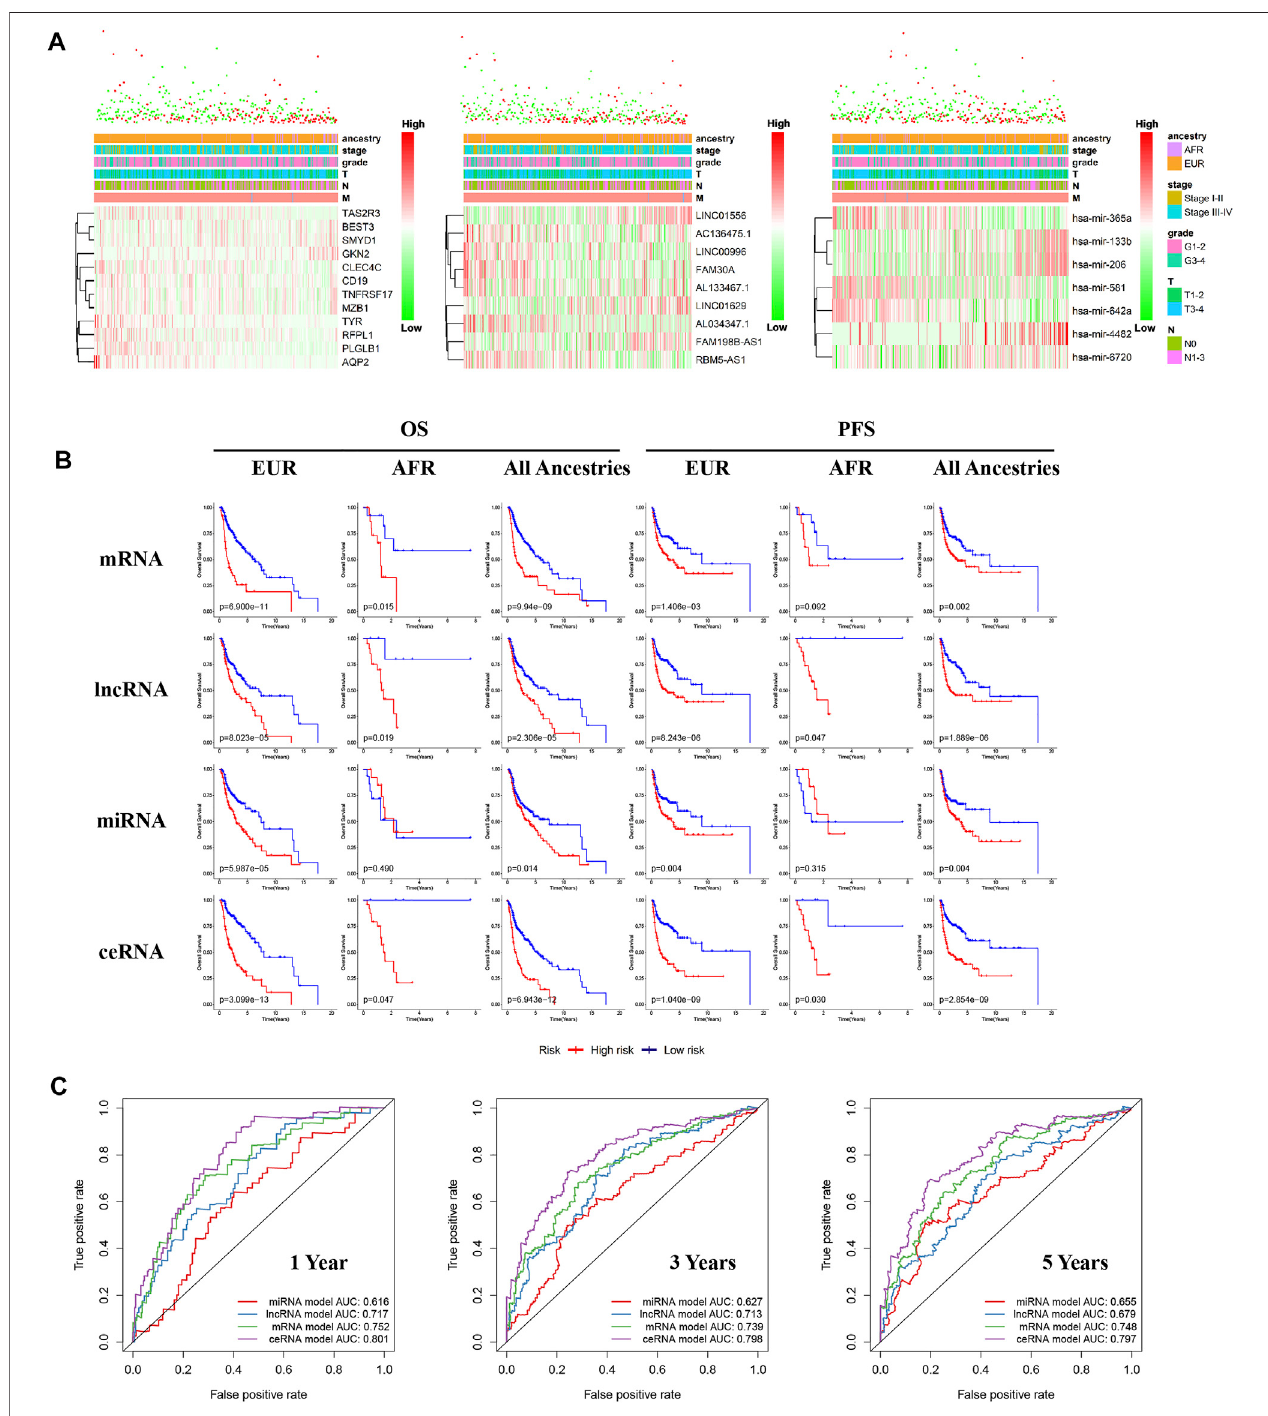
FIGURE 5 | Differences in ceRNA expression between EUR and AFR OSCC patients. (A) The multiclinical trait heat map of the mRNA, lncRNA, and miRNA risk regressionmodels (fromlefttoright). (B) ThemRNA,lncRNA,miRNA,and ceRNAriskregressionmodelswereusedtopredict theprognosesofOSCC patients ofEUR, AFR, and all genetic ancestries. (C) ROC curves for the prognosis at 1, 3, and 5 years from the four risk regression models.